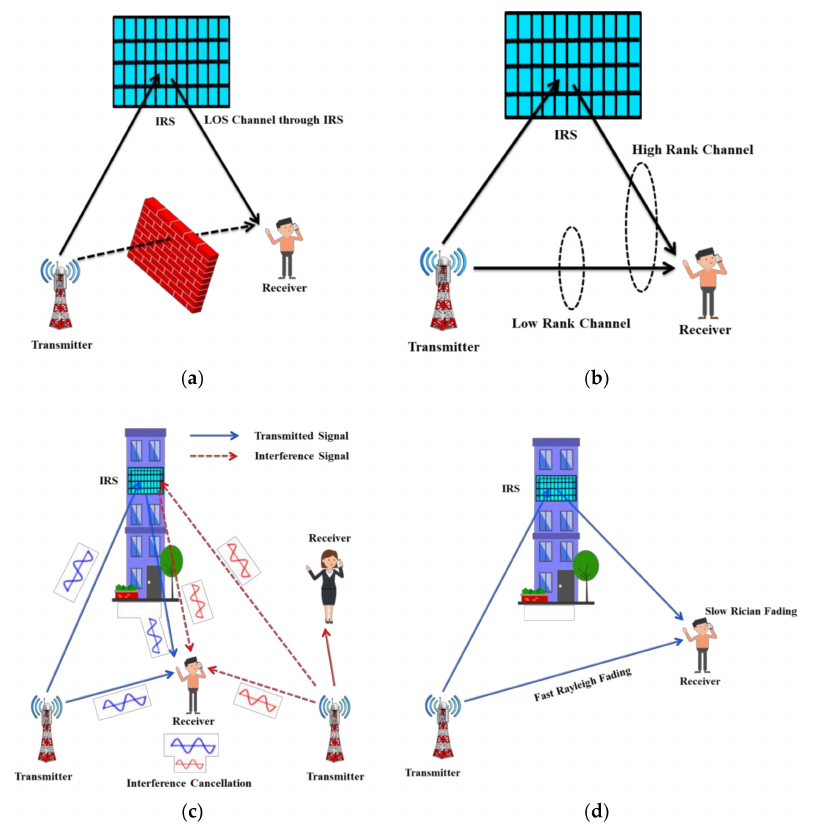
Figure 1. Main functionalities of IRS to reconfigure wireless propagation. ( a ) IRS for coverage extension; ( b ) IRS to enhance channel rank condition; ( c ) IRS to refine channel statistics; ( d ) IRS to suppress interference.